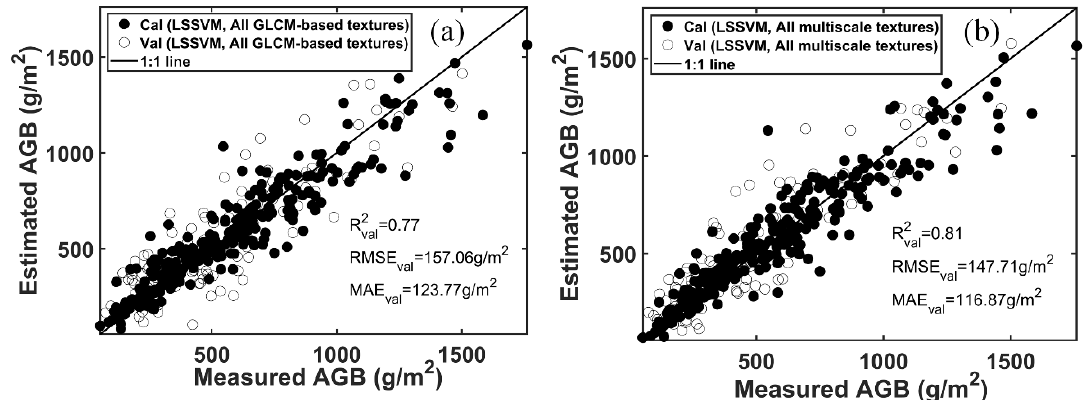
Figure A1. Predictive performance of the LSSVM regression models based on ( a ) all GLCM-based textures and ( b ) all multiscale textures for winter wheat AGB estimation.